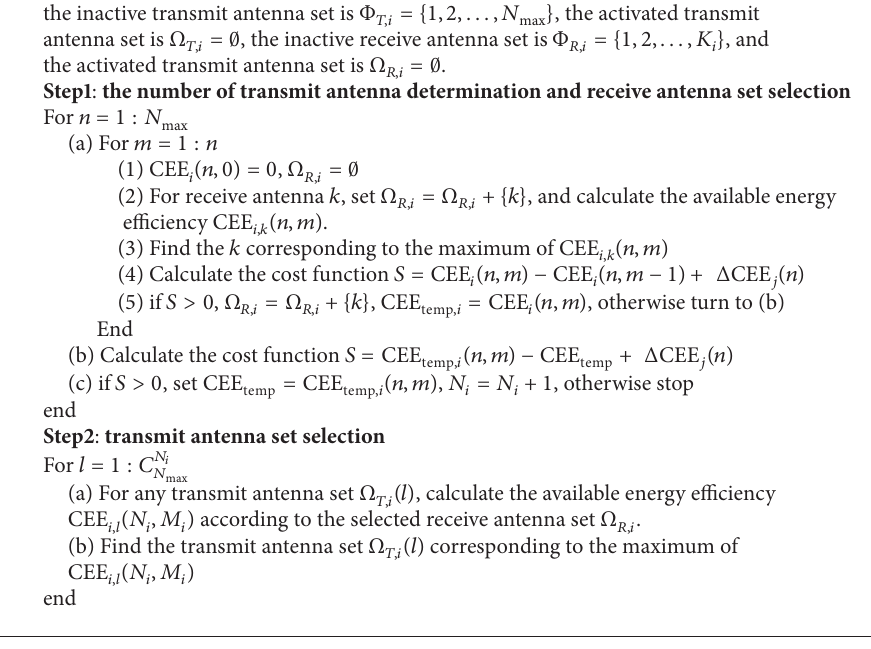
Algorithm 1: Cluster energy efficiency based antenna selection (cluster EEAS).